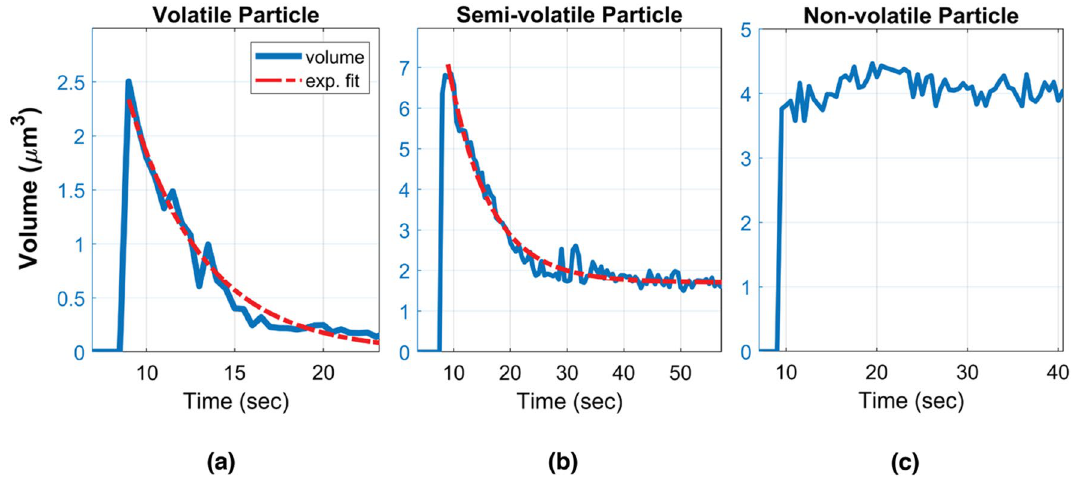
Figure 4. Characteristic volume changes of a ( a ) volatile, ( b ) semi-volatile and ( c ) non-volatile particle, sampled within the vape